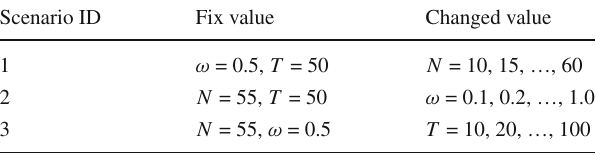
Table 4 Determination of the three main parameters, using the control variable method Scenario ID